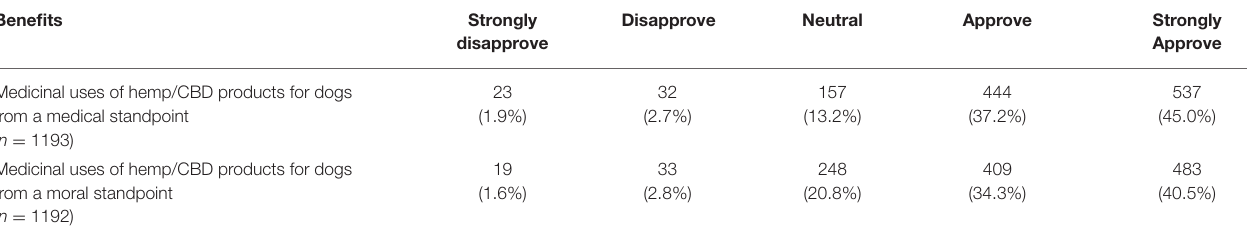
TABLE 12 | Participants’ reported level of support regarding the potential medical benefits of hemp/CBD/marijuana for dogs. Benefits Strongly Disapprove Neutral Approve Strongly disapprove